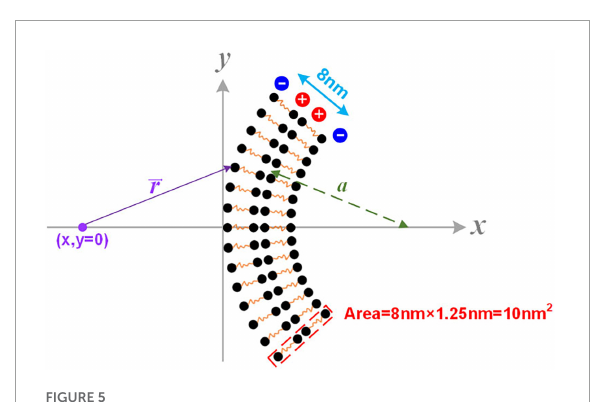
biological meaning hidden behind the divergence region.